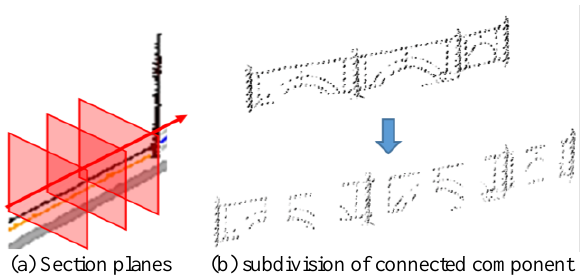
Figure 6. Subdivision along the vehicle trajectory